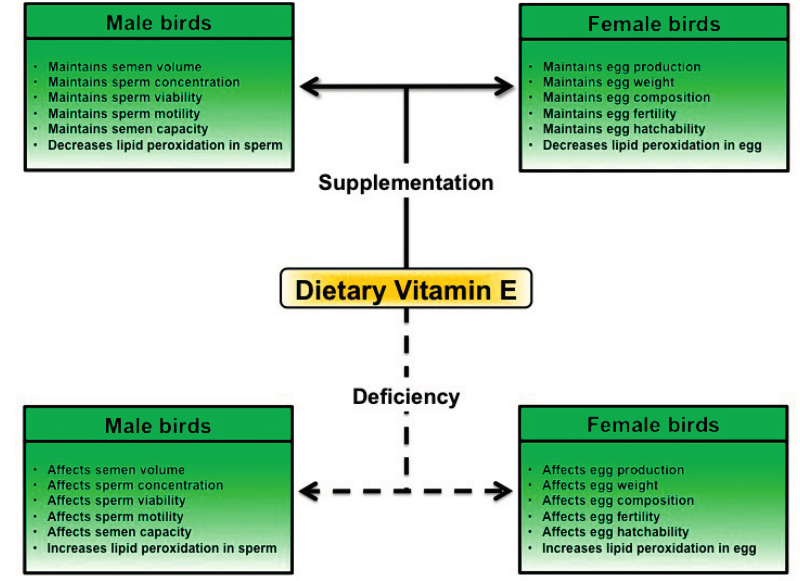
Figure 2. The main effects of dietary vitamin E supplementation on male and female fertility functions in poultry